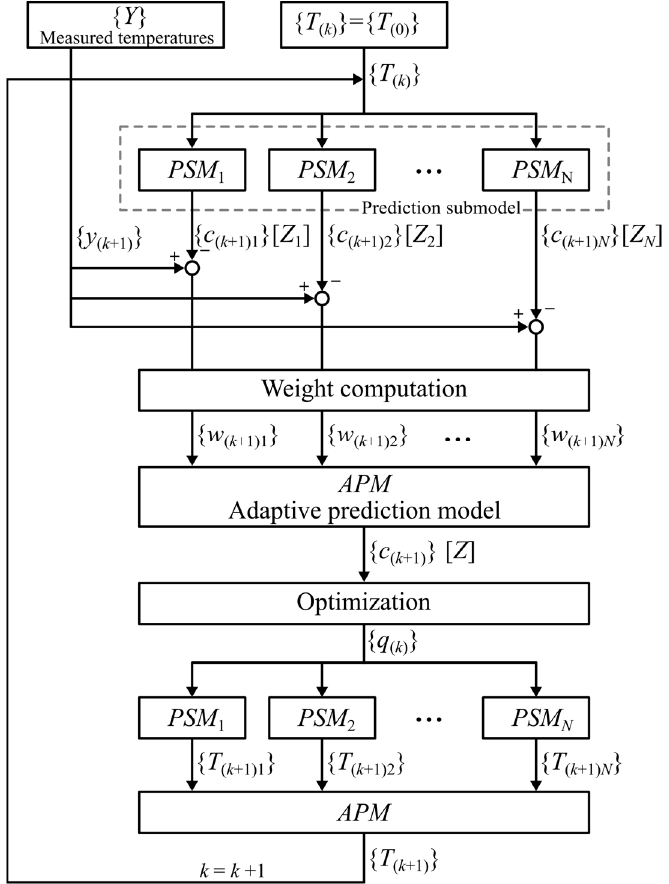
Figure 4. Adaptive model inverse system.